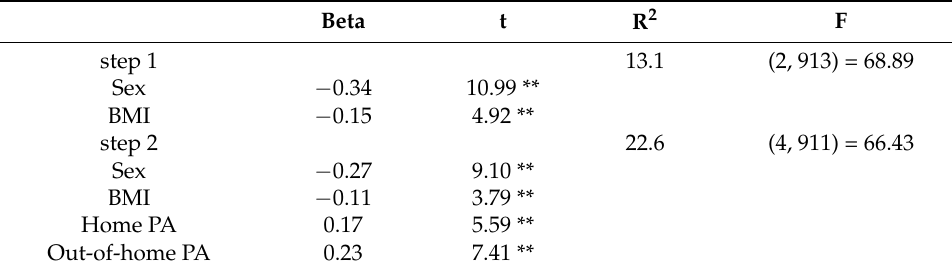
Table 5. Prediction of well-being from physical activity